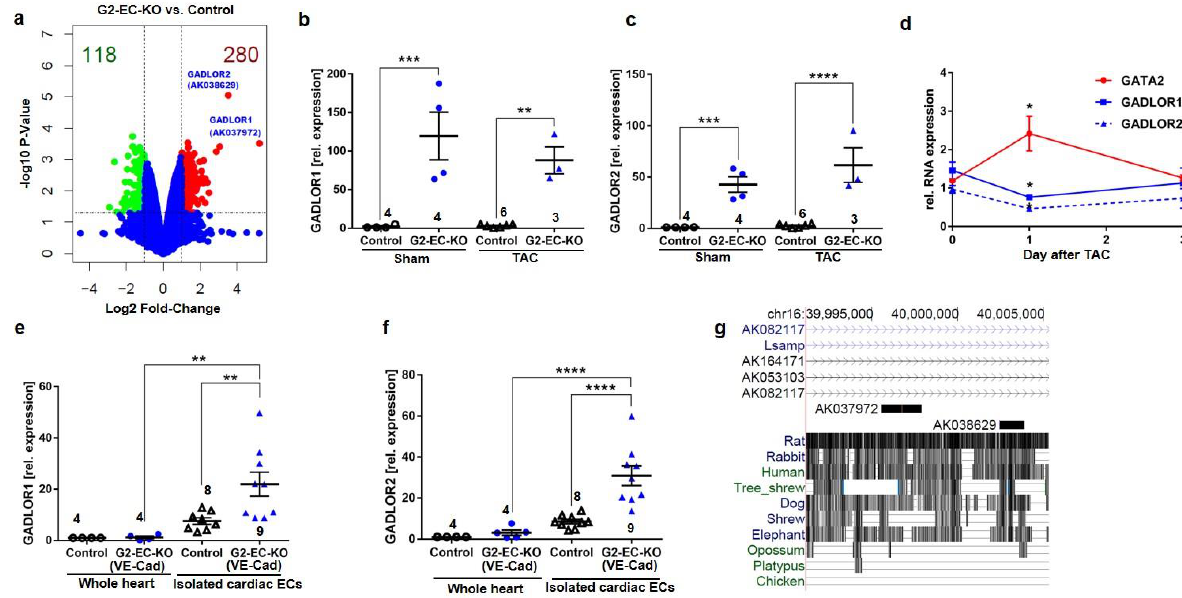
Figure 5. The lncRNAs GADLOR1 and 2 are upregulated in endothelial cells of G2-EC-KO mice. ( a ) Volcano plot of RNA expression from microarray of cardiac endothelial cells (EC) from indicated mice. Red dots indicate upregulated, green downregulated, and blue unregulated RNAs in G2-EC-KO ECs. ( b , c ) qPCR for GADLOR1 and 2 in mouse cardiac ECs. ( d ) qPCR of GATA2 and GADLOR1 and 2 in isolated EC; ( e , f ) qPCR of GADLOR1 and 2 in isolated cardiac ECs and whole hearts. ( g ) UCSC Genome Browser view of mouse chromosome 16, encoding GADLOR1 (AK037972) and 2 (AK038629). Data are mean ± sem; the number of biological replicates is shown in graphs; * p < 0.05, ** p < 0.01, *** p < 0.001, **** p < 0.0001.